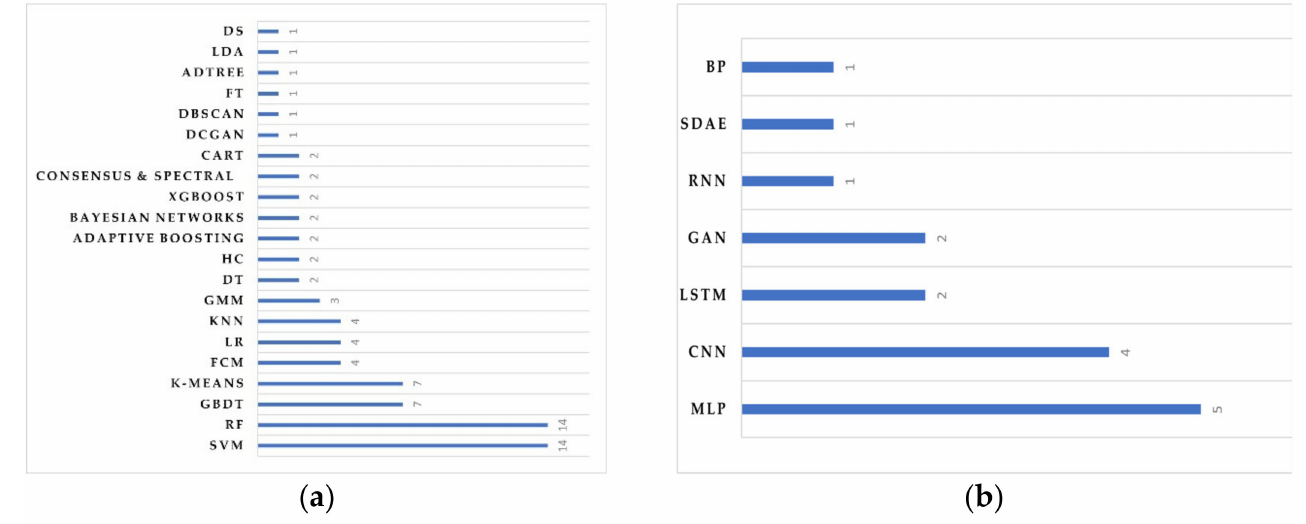
Figure 3. The distribution of machine learning algorithms ( a ) and deep learning algorithms ( b